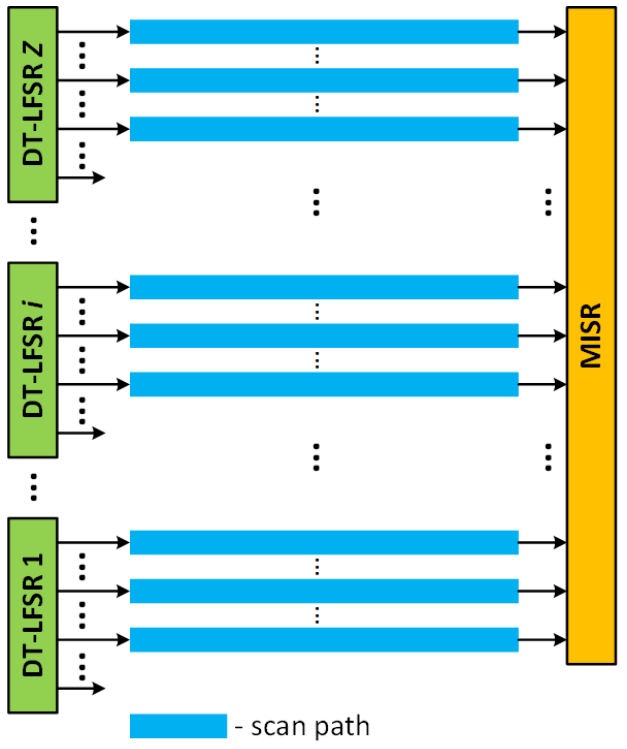
Figure 12. LBIST module with STUMPS architecture that uses a set of DT-LFSR registers as a generator of pseudo-random test patterns.